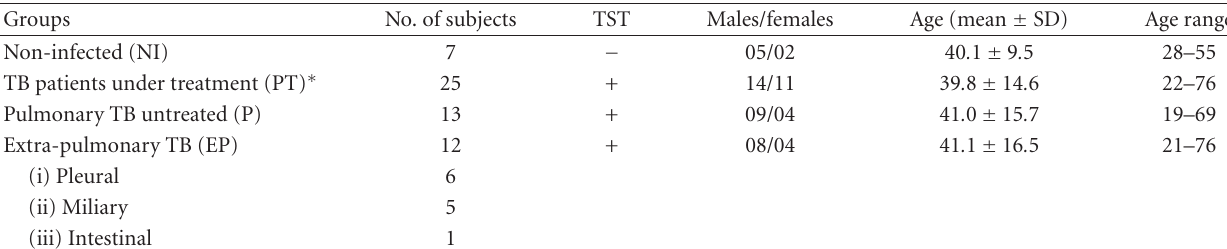
Table 1: Clinical characteristics of TB patients and controls in this